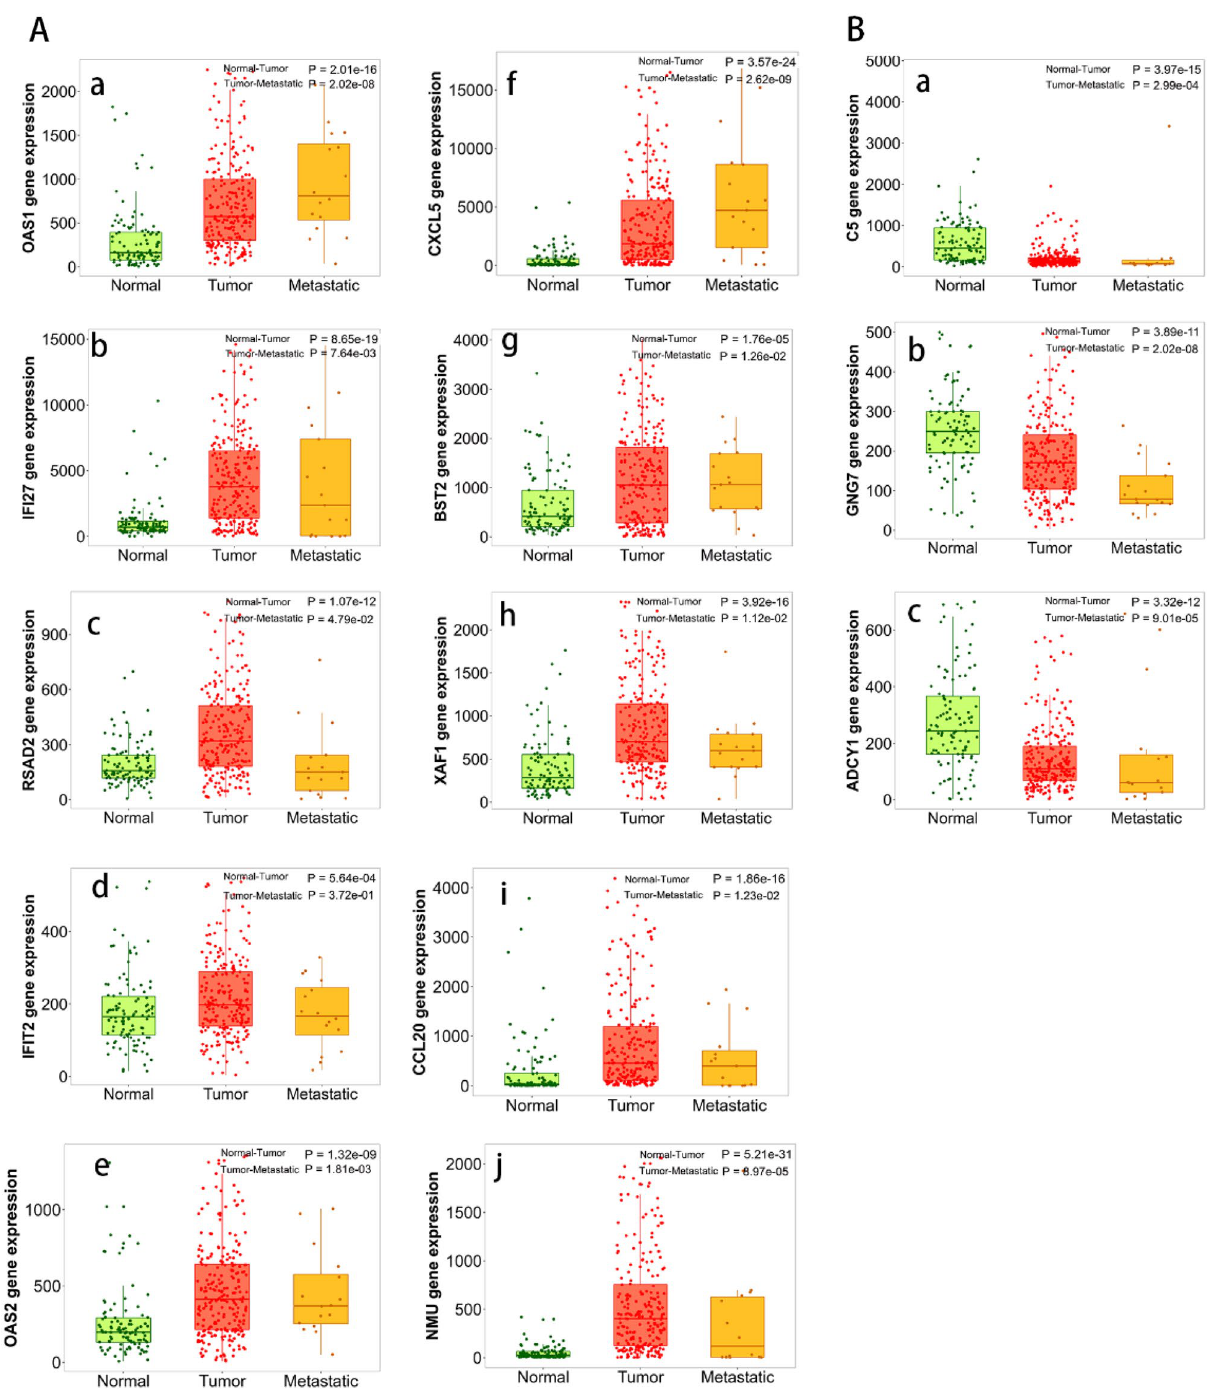
Figure 4. The comparison of the cluster of genes expression in normal, tumor, and metastatic tissues of PAAD patients in the TNMplot database (https:// www. tnmpl ot. com/). The 177 PAAD specimens were divided into high expression group and low expression group taking the median expression as the critical point. (A) 10 up-regulated genes significantly overexpressed in PAAD samples compared with normal tissues ( a – j ). The mRNA expression of OAS1, CXCL5, and BST2 in metastatic tissues was higher than tumor tissues ( a , f , g ). ( B ) The mRNA expression of 3 down-regulated genes was incrementally downregulated in the normal, tumor, and metastatic tissues ( a – c